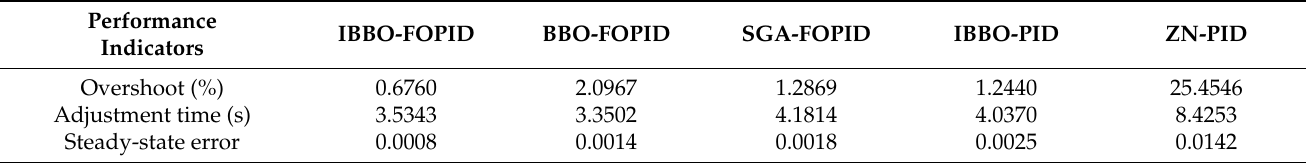
Table 3. Comparison of performance indicators of five algorithms.